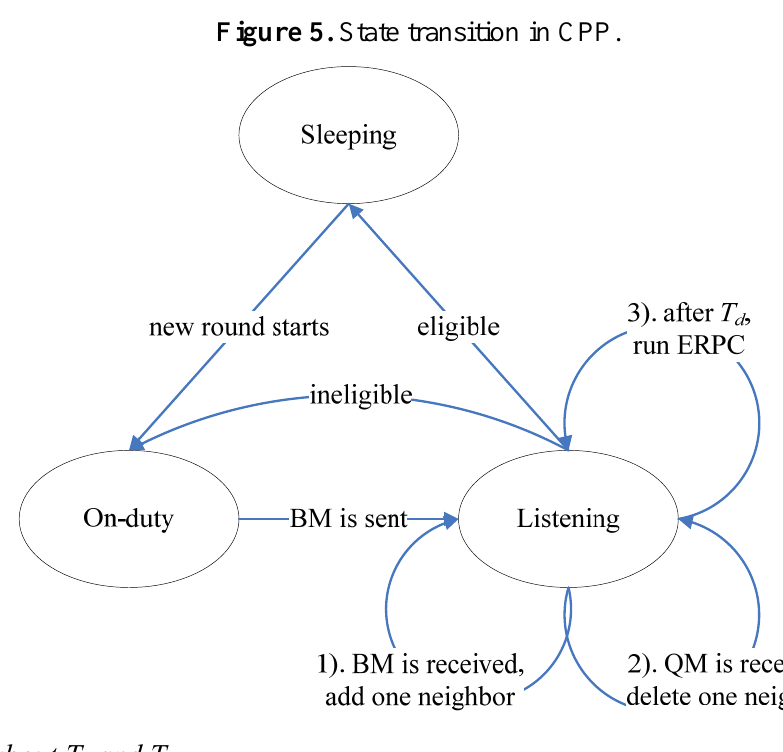
Figure 5. State transition in